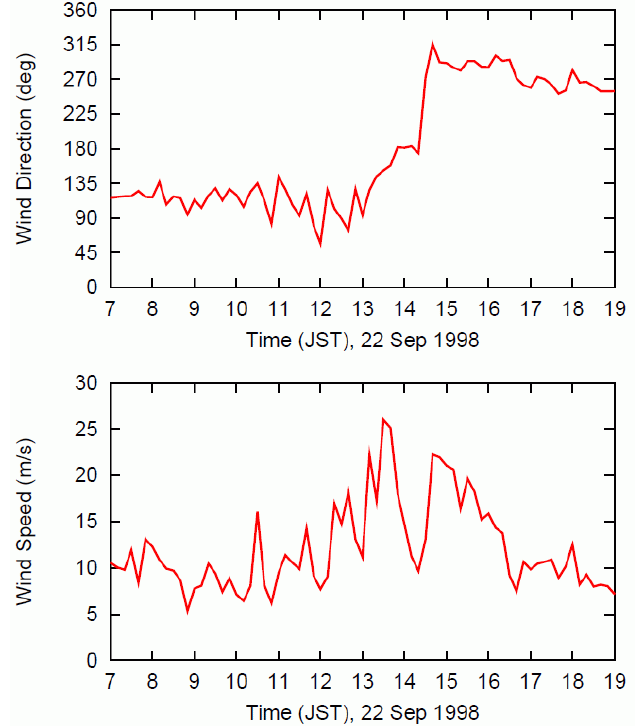
Figure 3. Time series of wind direction and speed at observation pole No. 2 at the wind farm under investigation on September 22, 1998. The wind directions 0, 90, 180, and 270 degrees represent northerly, easterly, southerly, and westerly winds, respectively.